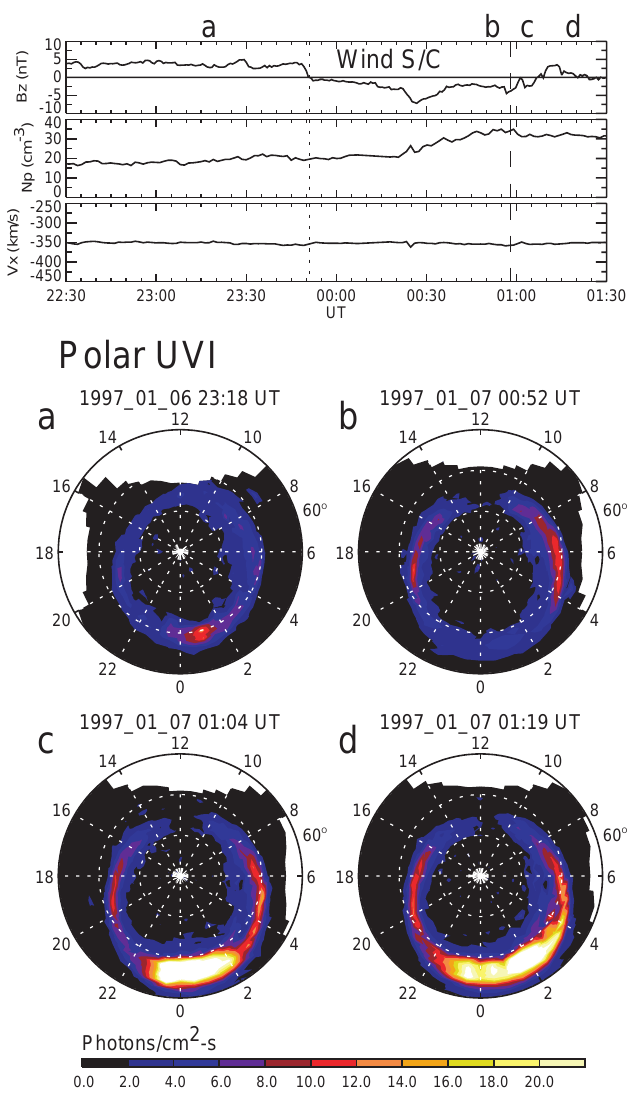
Fig. 1. A demonstration of two-component auroras, the two-cell aurora and the substorm aurora. (a) Auroral activity was weak. (b) The two-cell aurora became prominent as southward IMF sustained. (c) A substorm added an additional auroral feature to the nightside. (d) The substorm continuously increased its strength. The corresponding solar wind conditions for the four images are shown in the solar wind measurements from the Wind spacecraft, which are labeled in a–d. The vertical dotted (dashed) line in the solar wind measurements denotes the southward IMF turning (the substorm expansion onset) (From Shue et al.,